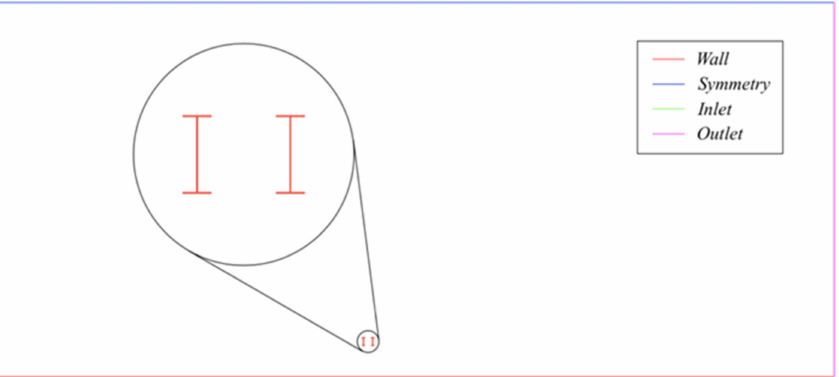
Figure 3. View of the complete fluid domain, with the boundary conditions used. In the case studies with z 0 = 120 m, the bottom edge was also set as a symmetry boundary condition (single or double column, B&W in the printed